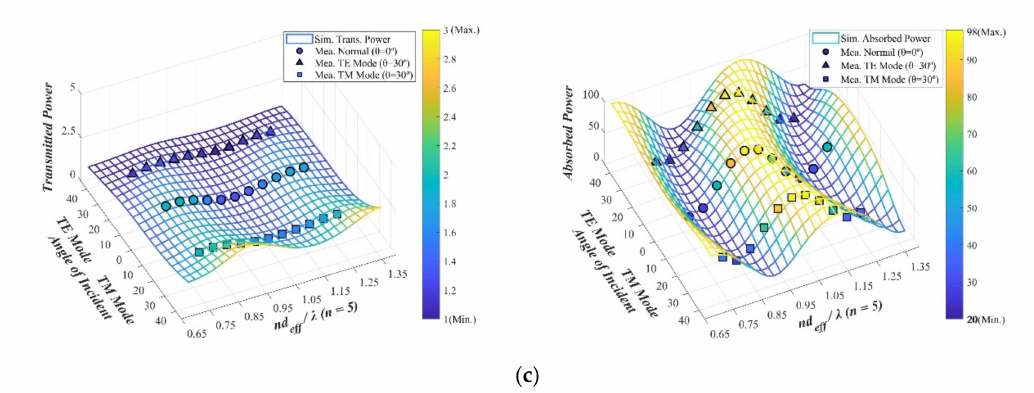
Figure 4. The performance of the fabricated optical transparent absorber for oblique incidence (simulated (Sim.) and measured (Mea.) results for the transmission and absorption characteristic in %): ( a ) sample 1, ( b ) sample 2, and ( c ) sample